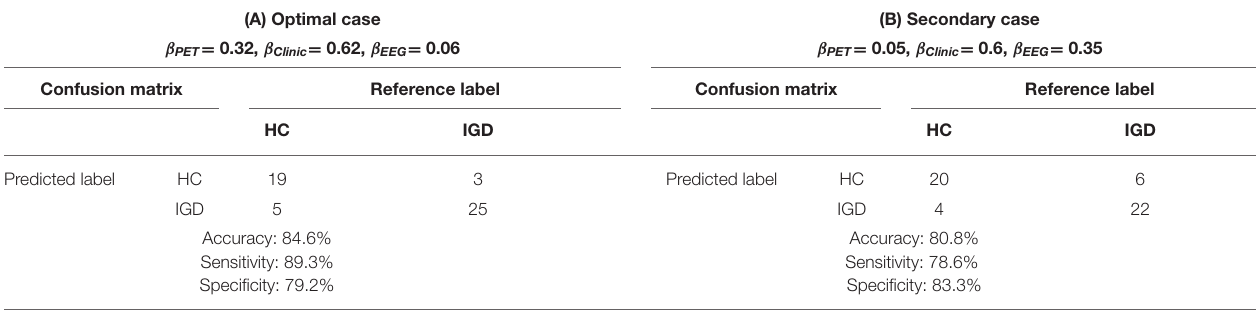
TABLE 2 | Proposed prediction rule based on multiple-kernel SVM. (A) Optimal